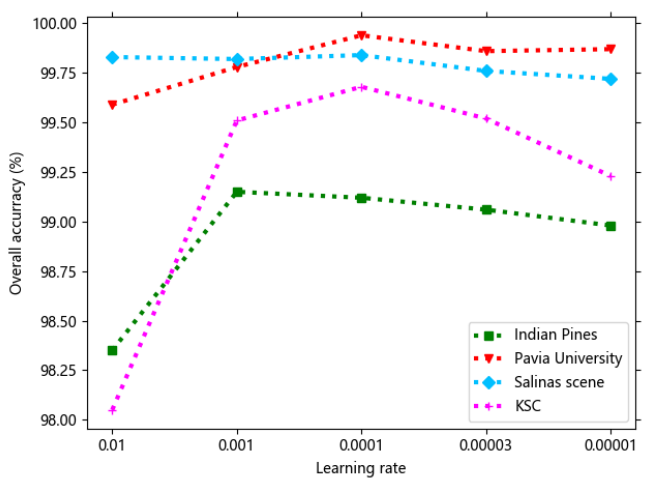
Figure 8. Overall accuracy of the four hyperspectral datasets when selecting different learning rates in the MSSN.